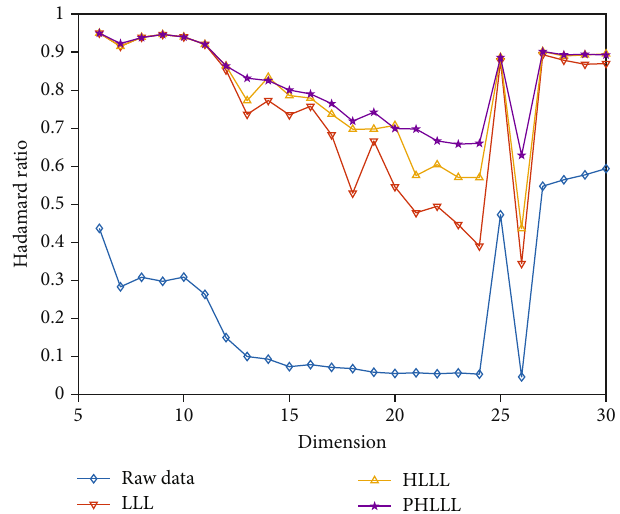
Figure 2: Hadamard ratio comparison in four cases.